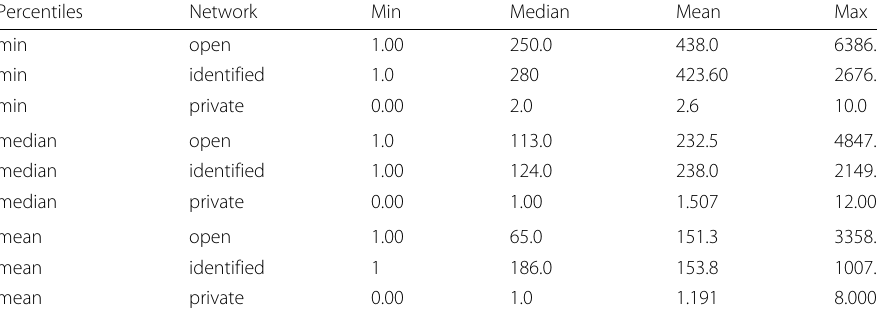
Table 17 Degree distributions of the open protein networks, the identified nodes in the experimentation and the private networks according to combined score percentile